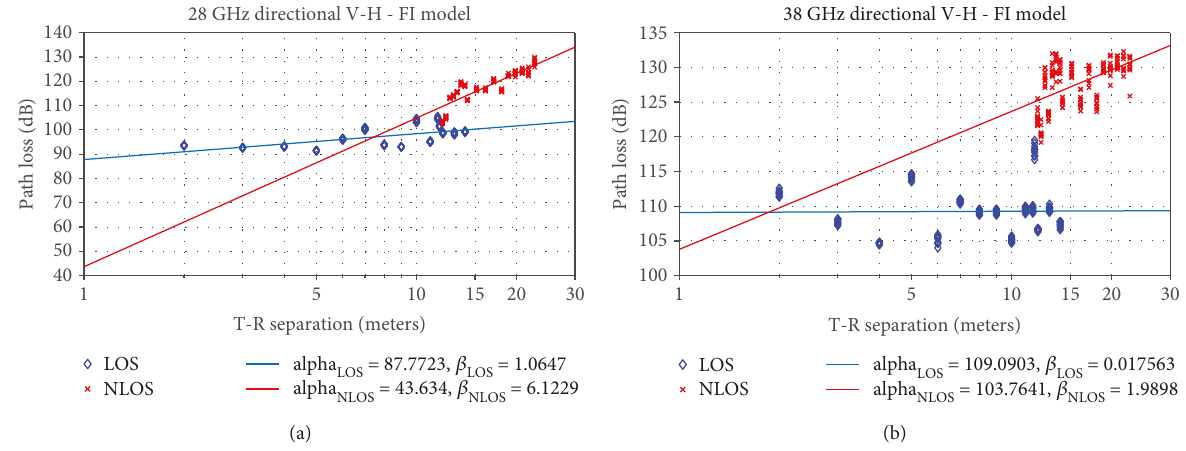
Figure 6: Directional V-H FI path loss model for LOS and NLOS (a) 28 GHz and (b)